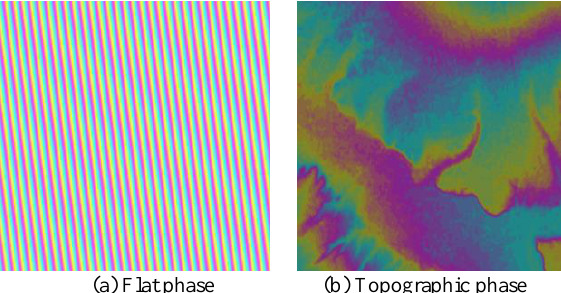
Figure 5. Simulated results of the flat phase and topographic phase.